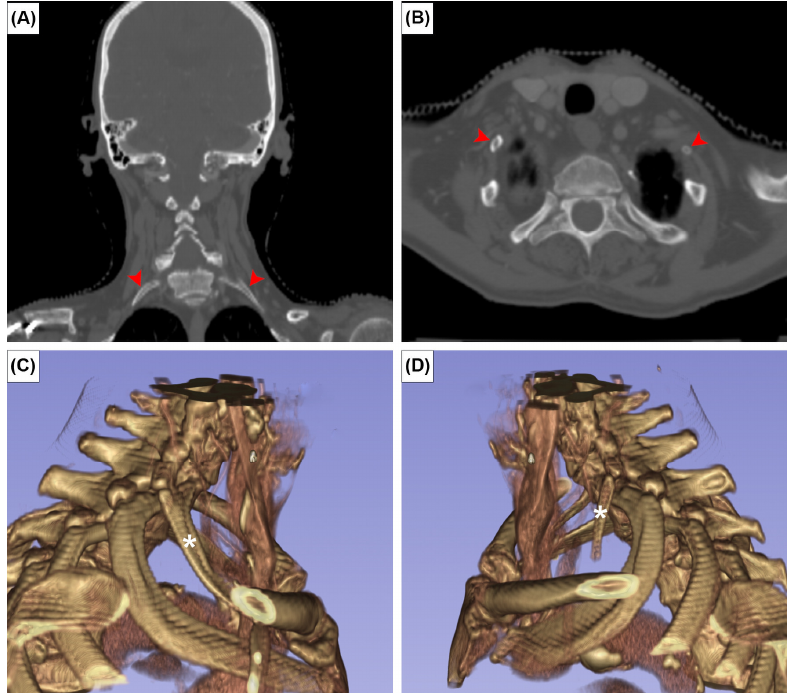
Figure 3. Coronal ( A ), axial CT images ( B ) and three-dimensional reconstruction of right ( C ) and left ( D ) cervical ribs. Red arrowheads and asterisks indicate the cervical ribs.